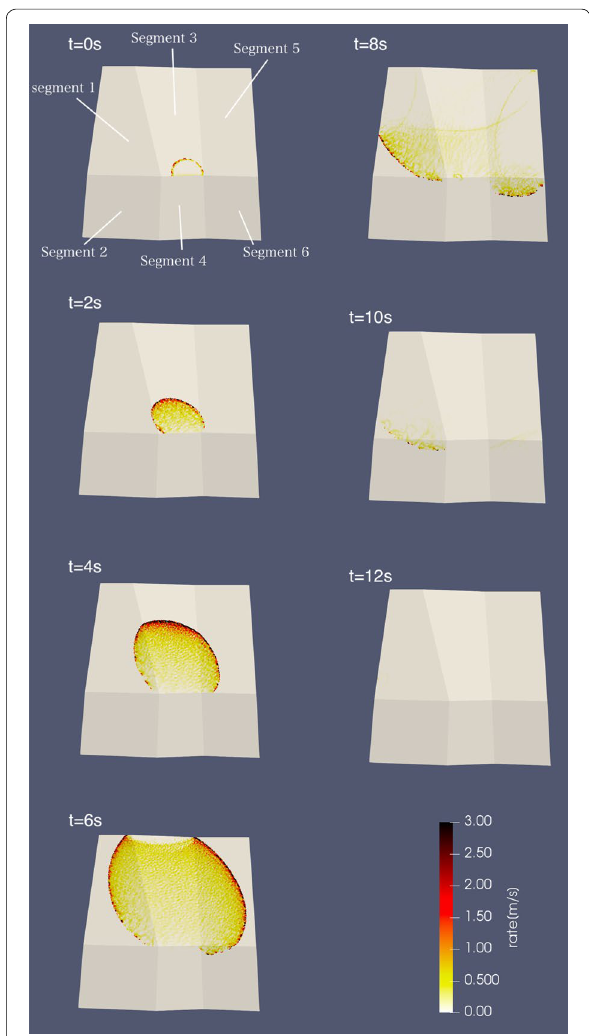
Fig. 5 Snapshots of slip rate for Model 5 at every 2 s from 0 to 12 s. View from the